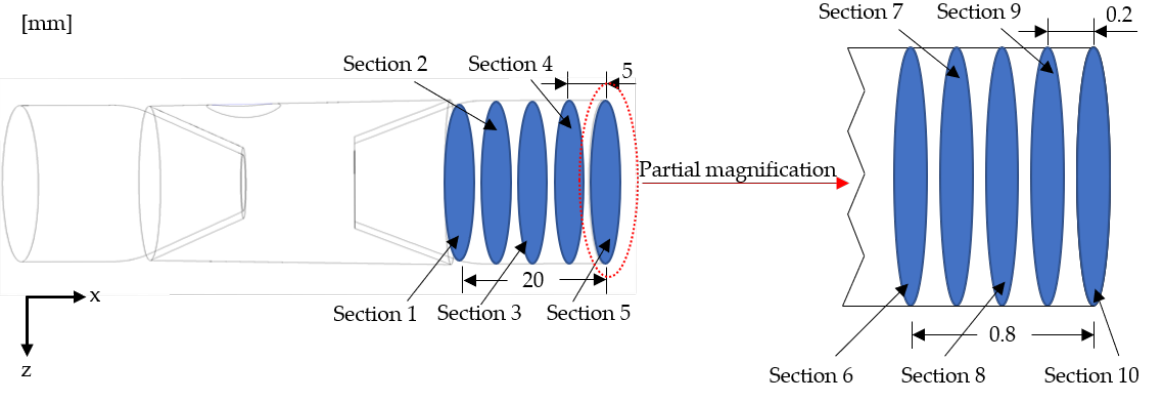
Figure 3. Schematic diagram of section division.